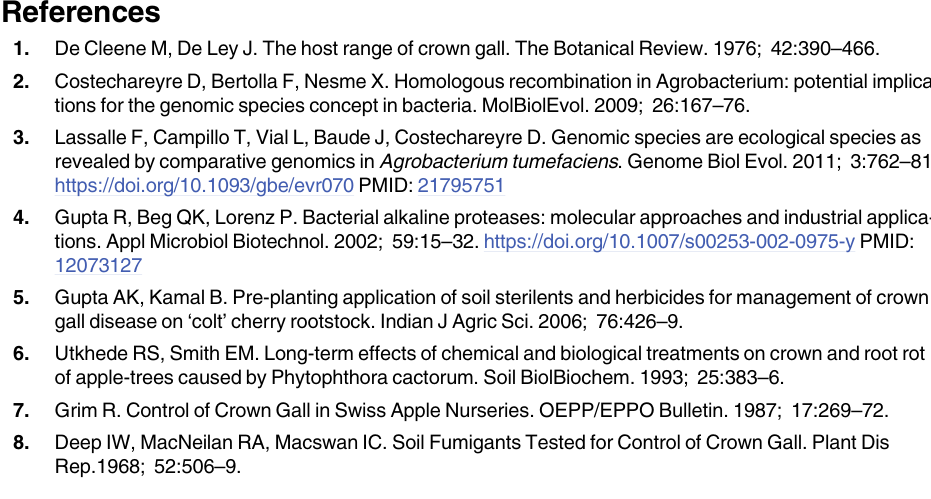
S6 Fig. Neighbor Joining (NJ) phylogeny of bacteria belonging to the Operational Group Bacillus amyloliquefaciens as reconstructed from concatenated purH marker sequences. Terminal branches are labelled by GenBank accession number, genus, species and strain desig- nations. The isolate under study is displayed in bold type. Numbers on internal branches indi- cate bootstrap support percentages. The size bar corresponds to 1% sequence divergence along horizontal branches. The orthologous sequence from the related bacterium Bacillus subtilis subsp. spizenii served as outgroup to root the